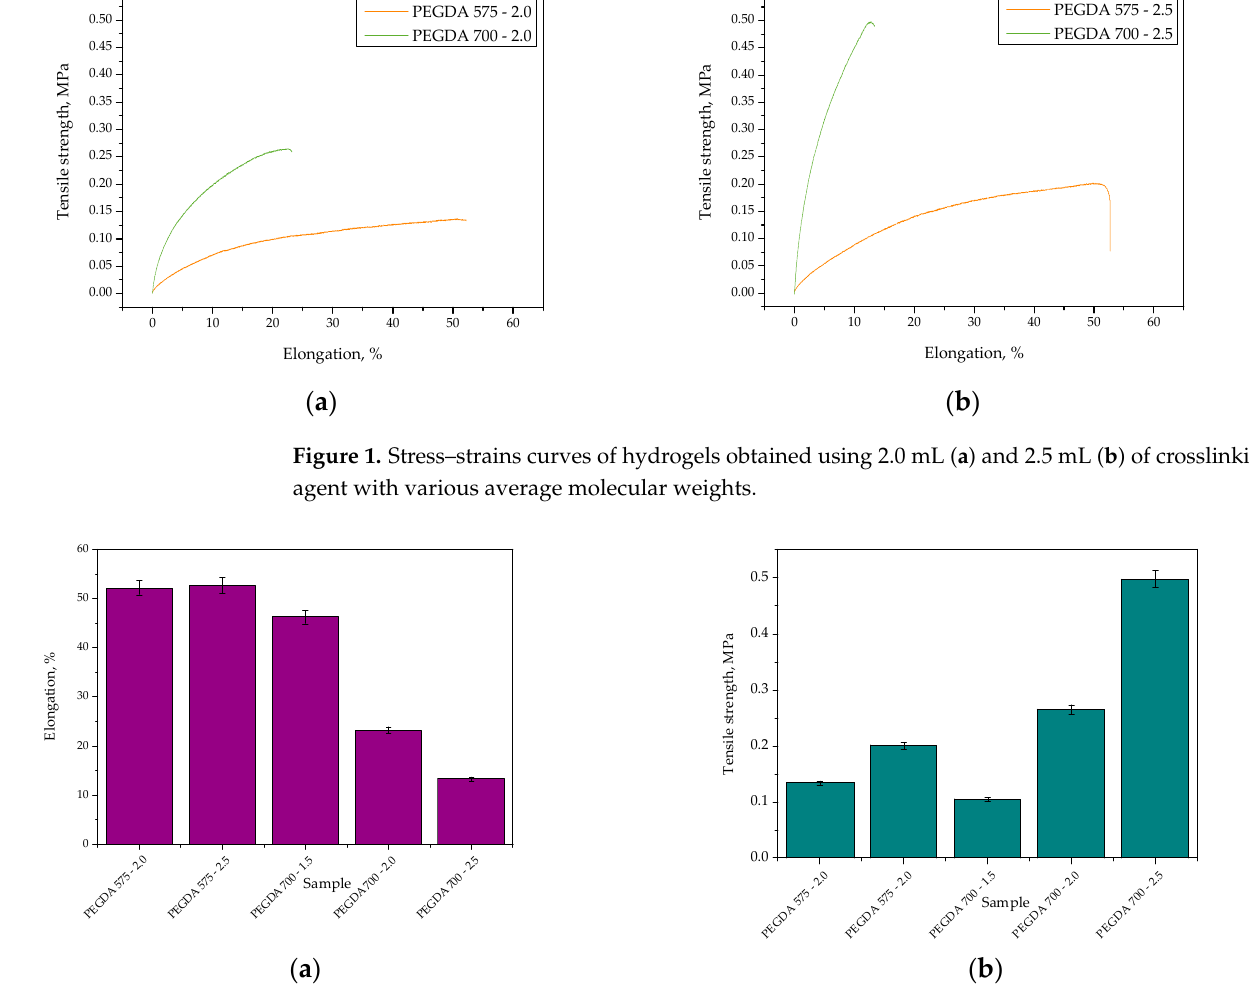
Figure 2. Percentage elongation of hydrogels ( a ) and their tensile strength ( b ).